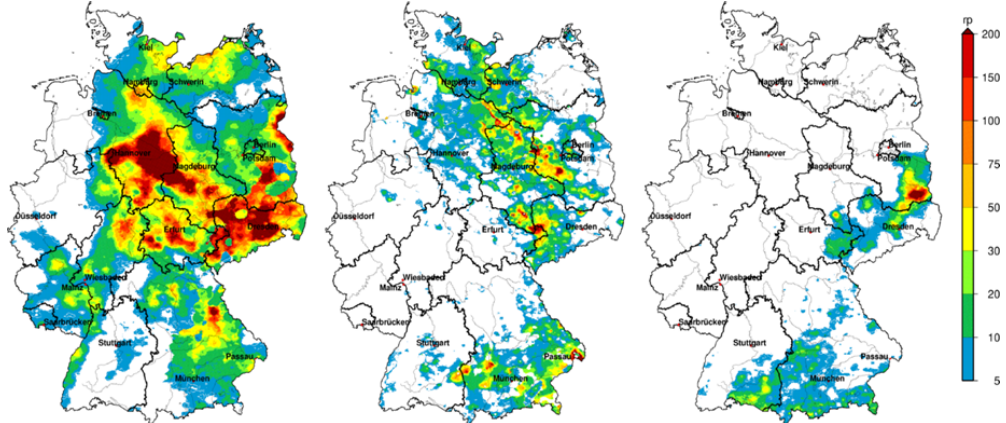
Figure 8. Return periods of the API displayed in Fig. 7 derived from 30-day API of large-scale floods in the period from 1960 to 2009: June 2013 (left), August 2002 (middle) and July 1954